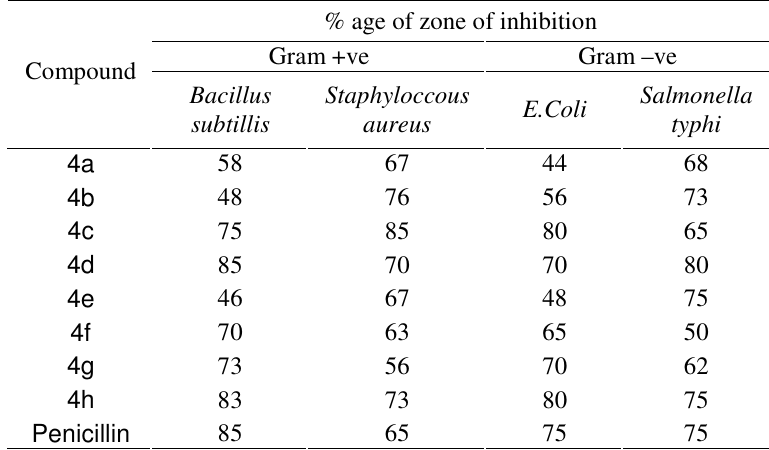
Table 4. Antibacterial Activity of compounds